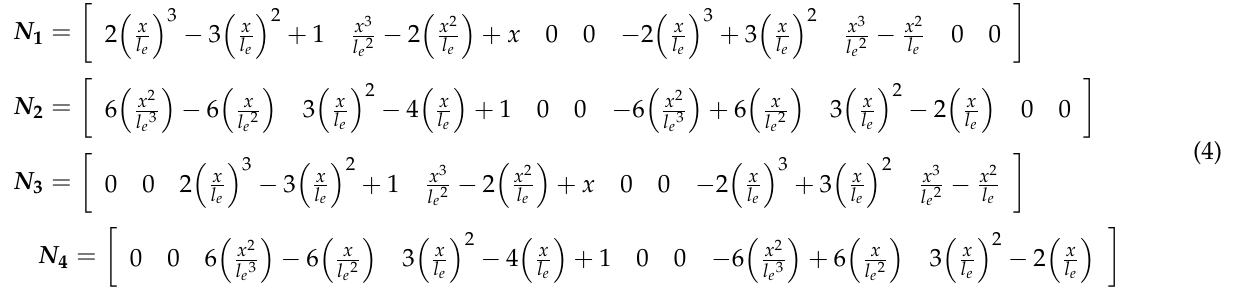
Figure 3. The element of the EVES beam.